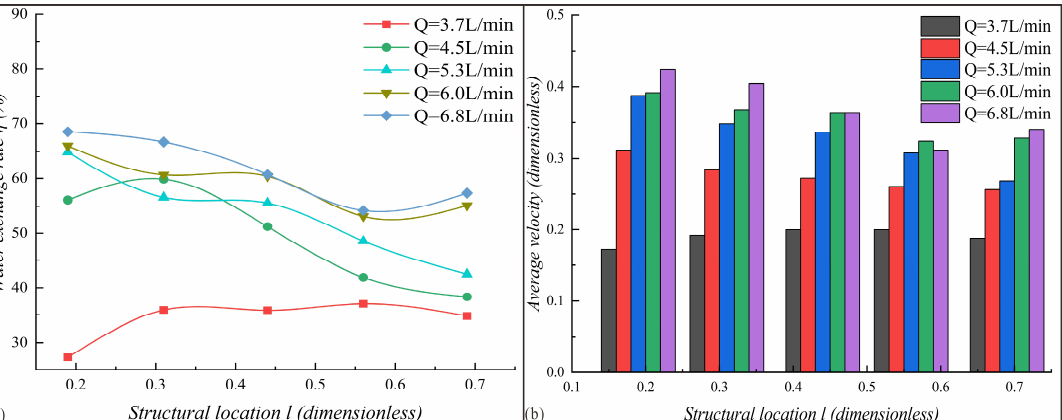
Figure 9. Calculation results for the triangular prism: ( a ) water exchange rate; ( b ) average velocity.